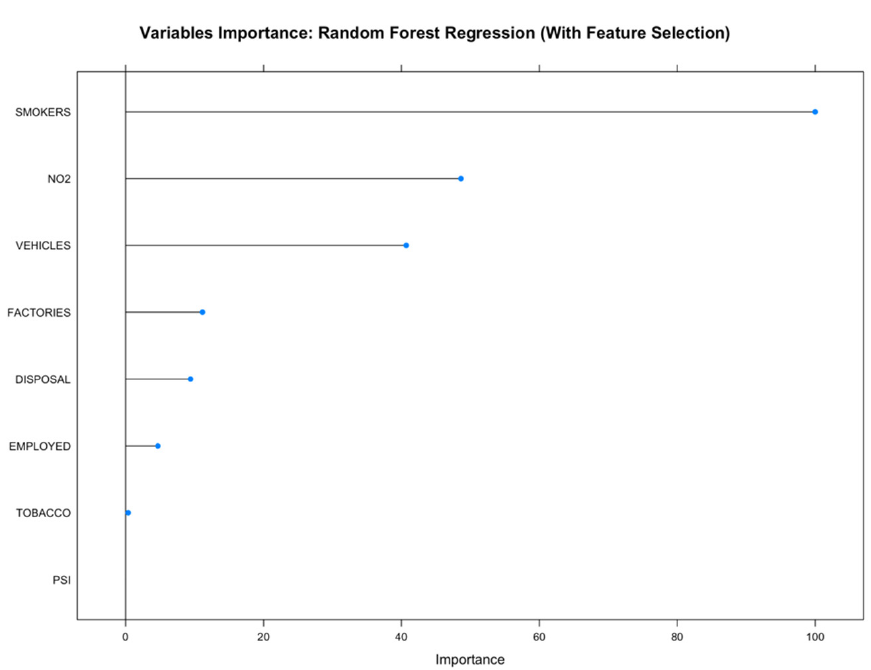
Figure 5. Variable importance of the random forest models.